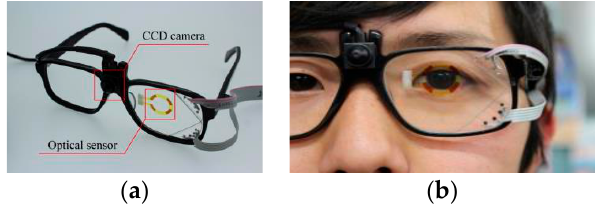
Figure 1. ( a ) See-through-type wearable eye-tracking system. The colored parts are dye-sensitized photovoltaic cells that detect the light reflected from the eye and deduce the pupil position and eye blink. A charge-coupled device (CCD) camera is used to detect the line of sight of the user. When we only need to detect the movement of the eye and eye blinking, the CCD camera is not used and no external power is necessary. ( b ) The eye-tracking system in use. Since the distance between the sensor cells and the eye is a few centimeters, the user does not notice the cells and can see through them as if he/she were wearing sunglasses with the color of the dye.